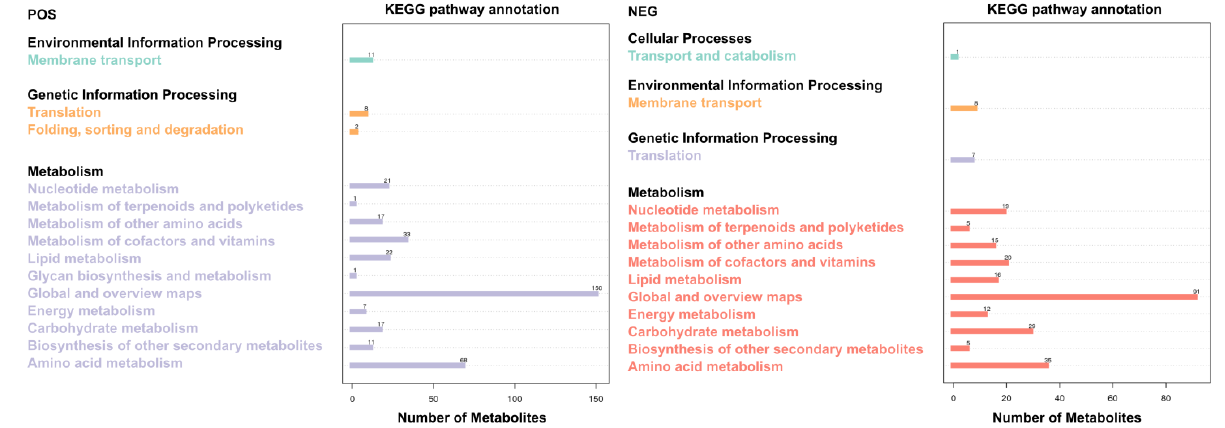
Figure 9. Significantly different metabolites are involved in metabolic pathways. The abscissa represents the number of metabolites, while the ordinate represents the annotated KEGG pathway; the diagram shows the number of metabolites annotated by each secondary classification under the primary classification of pathways. POS: positive ion mode; NEG: negative ion mode.